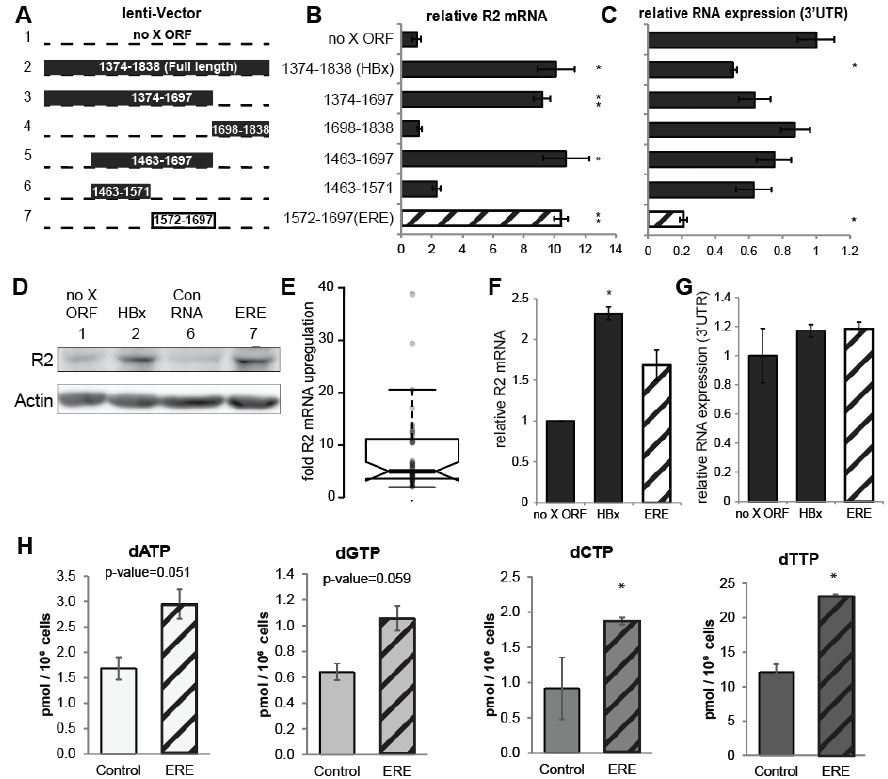
Figure 2. Delineation of the HBx RNA minimal sequence required for RNR-R2 upregulation. ( A ) Schematic representation of the truncated HBx gene in LV constructs. The black regions were cloned for expression. The standard numbering from the EcoRI site in the HBV genome is indicated. As in Figure 1B, the constructs are framed by an HA-tag 5 (cid:48) and the HBx endogenous 3 (cid:48) UTR. ( B , C ) The constructs in panel A were transduced into non-cycling HepG2 cells. Relative RNR-R2 mRNA ( B ) and 3 (cid:48) UTR ( C ) levels were measured by qRT-PCR from three biological replicates. * p -value < 0.05, ** p -value < 0.01 were calculated for each sample compared to vector control using Student’s t -test. ( D ) As in ( B ), Vector, 1.3x HBV or constructs 1, 2, 6, and 7 depicted in A were transduced into quiescent HepG2 cells and Western blot analysis with antibody for R2 was performed. Actin was used as loading control. ( E ) Boxplot of the fold changes of RNR-R2 expression between ERE and the control RNA of 45 biological replicates is shown. Student’s t -test was performed, and the results are highly significant ( p < 0.0001). The boxplot was created with help of the BoxPlotR web-tool (http://shiny.chemgrid.org/boxplotr/ accessed on 28 November 2021). ( F ) Primary human hepatocytes (PHH) were transduced with LV HBx or ERE or no HBx ORF. Relative RNR-R2 mRNA levels of biological duplicates were measured by qRT-PCR. Student’s t -test was performed showing a p -value of <0.05 for the HBx sample. ERE was non-significant due to the low number of samples. ( G ) As in F, LV RNA levels (3 (cid:48) UTR) were measured by qRT-PCR to assure similar expression of the constructs. The LV expression levels did not change significantly. ( H ) dNTP levels in quiescent HepG2 cells transduced with ERE or control from three biological replicates were measured by LC/MS. The levels for each dNTP are shown and Student’s t -test was performed. * p -value < 0.05, non-labeled samples are